Question: Compose a caption that would accompany this figure in a paper.
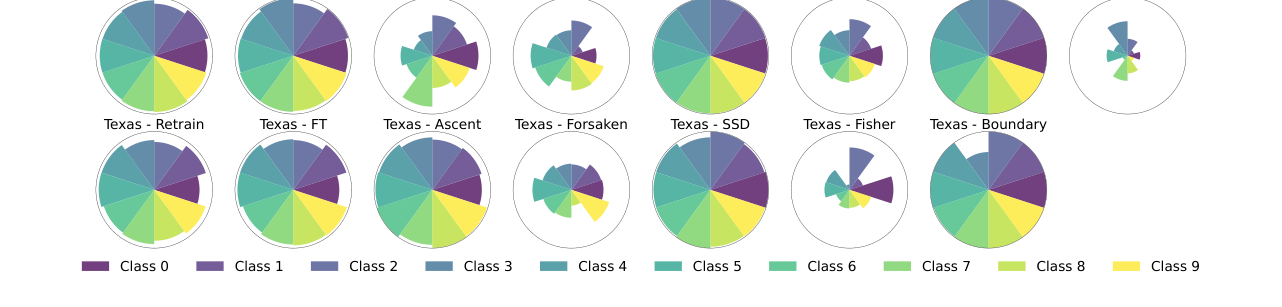
Answer: Partial class unlearning results (AUC) of 10 classes